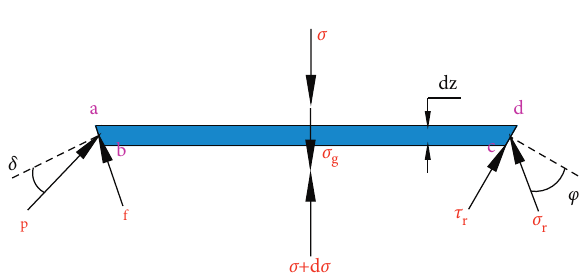
Figure 2: Stress distribution of the element